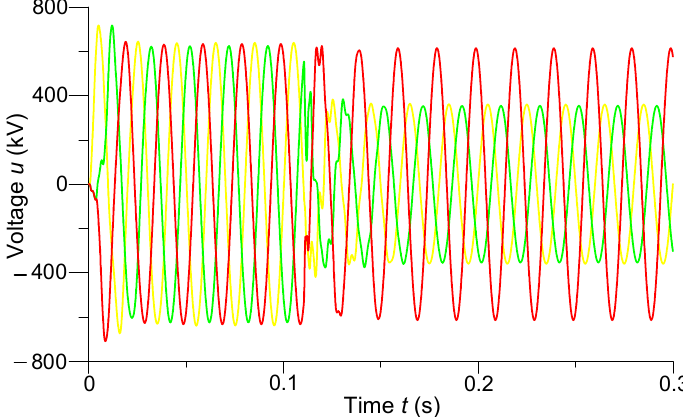
Figure 4. Transient processes of phase voltages in the middle of the line.